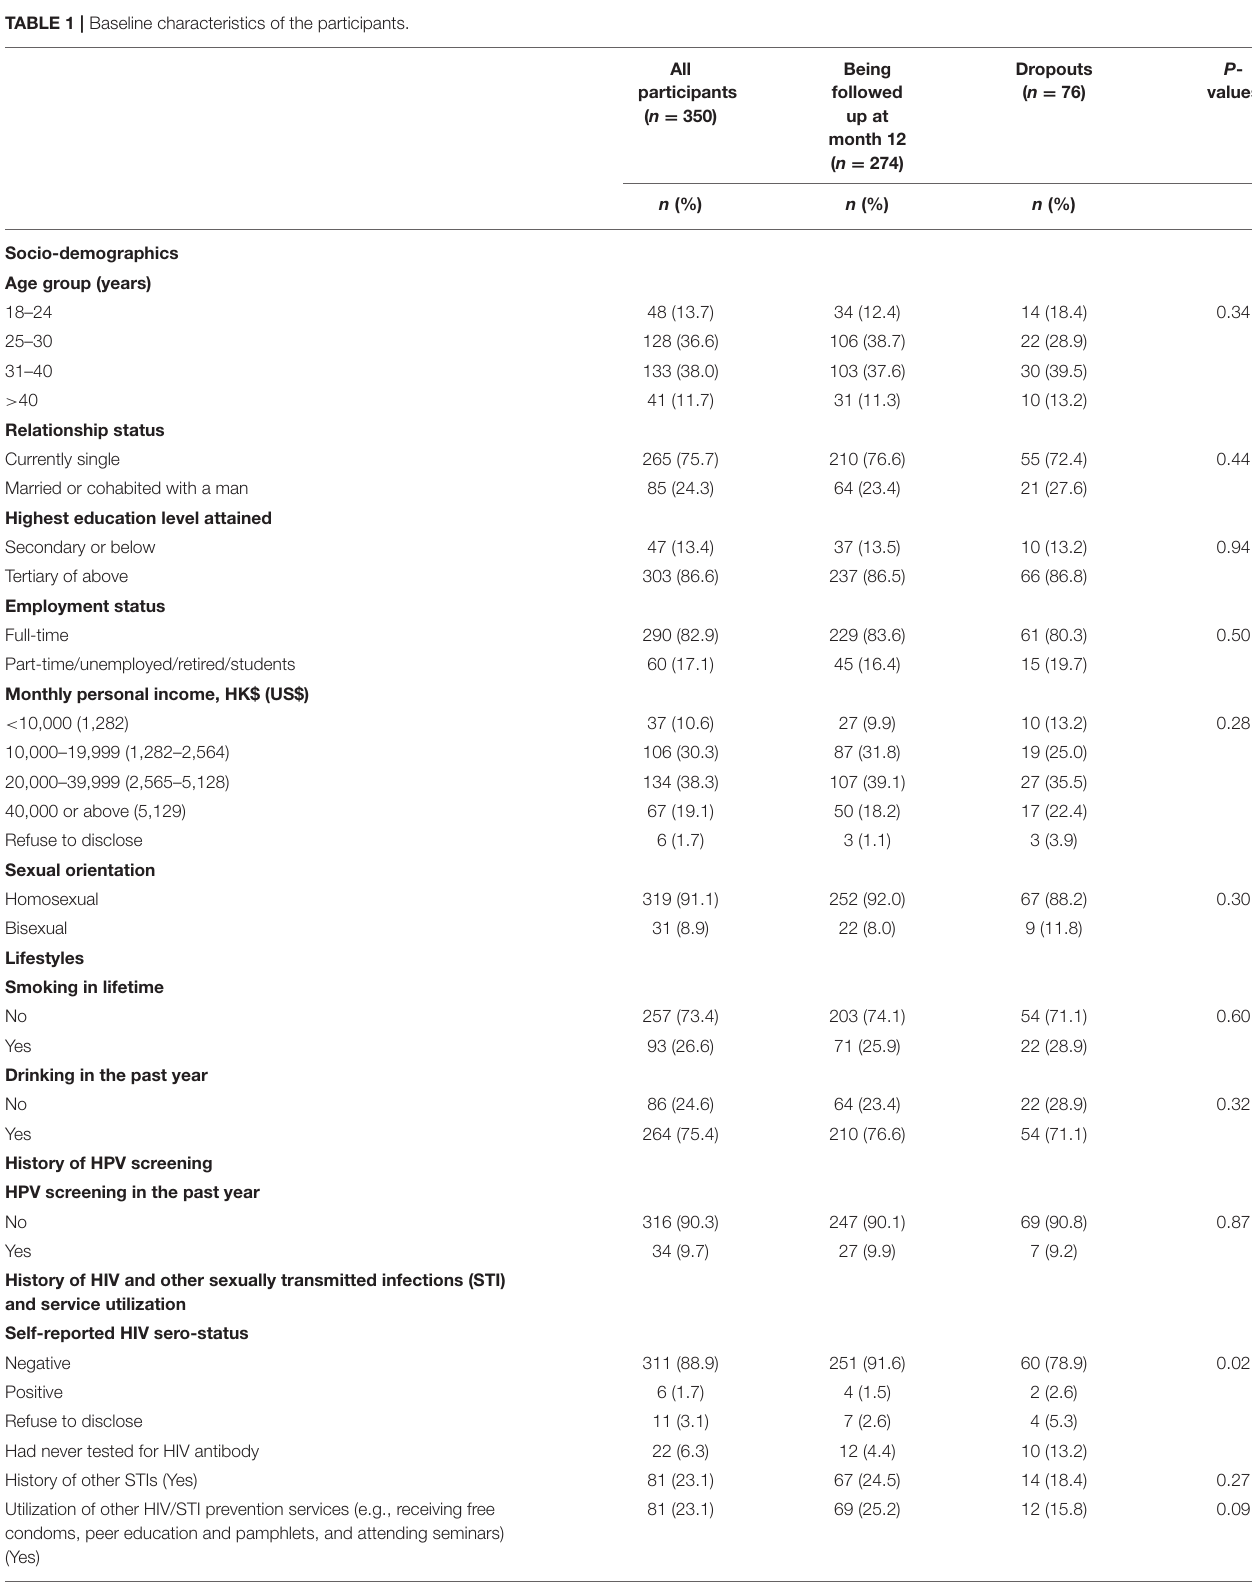
TABLE 1 | Baseline characteristics of the participants.